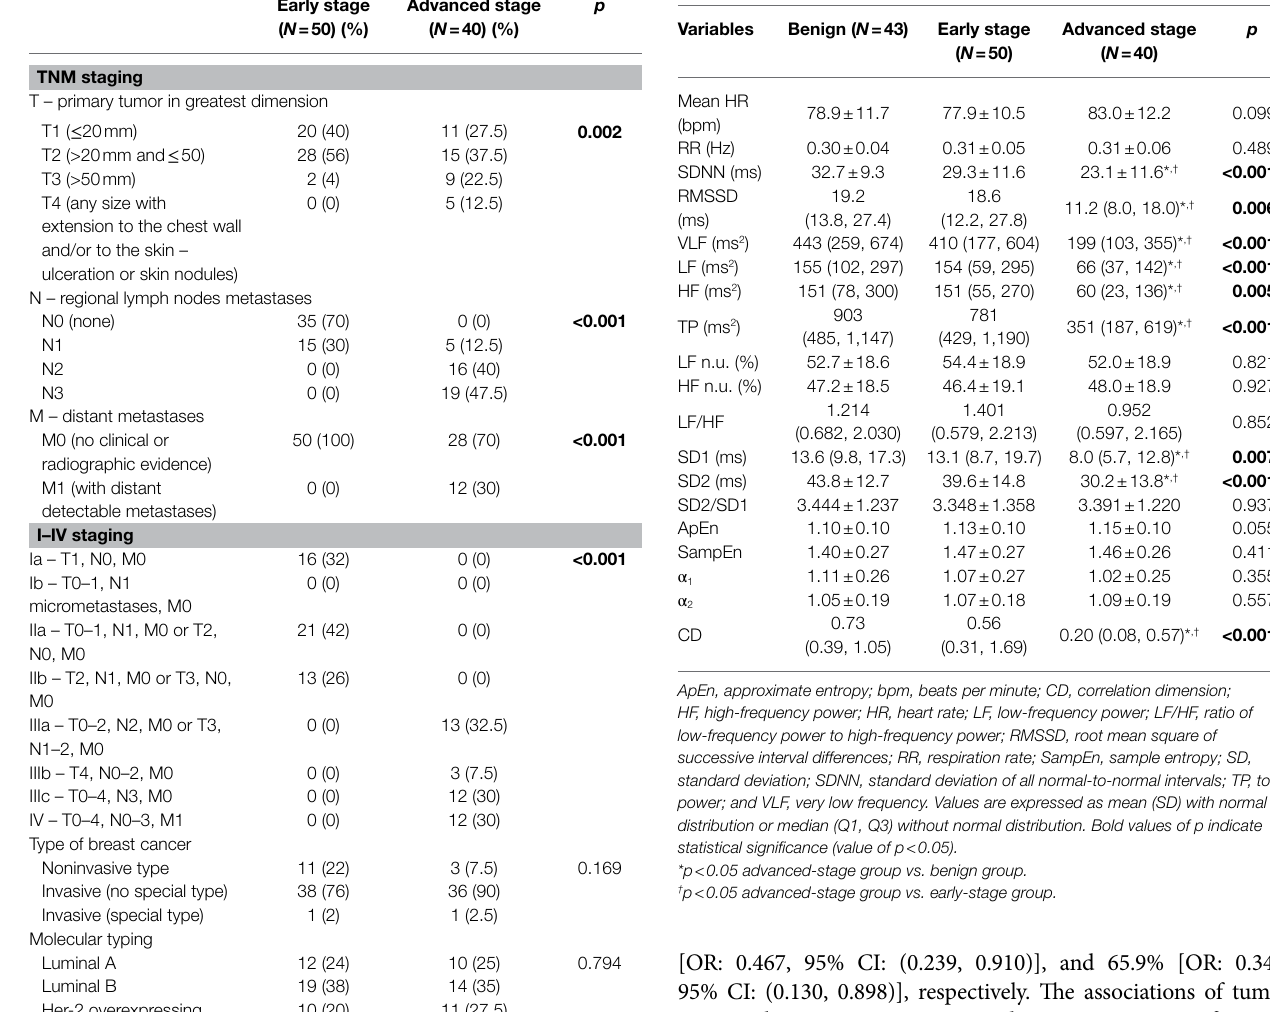
advanced-stage groups. Variables